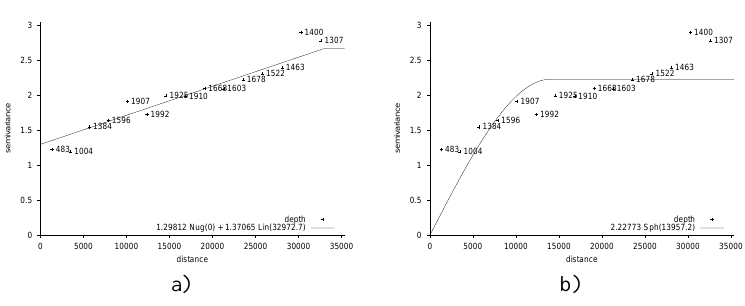
Figure 3. a) linear semivariogram of depth; b) spherical semivariogram of depth. Table 3. Types of semivariogram models of depth and the parameters: range, sill and nugget effect.